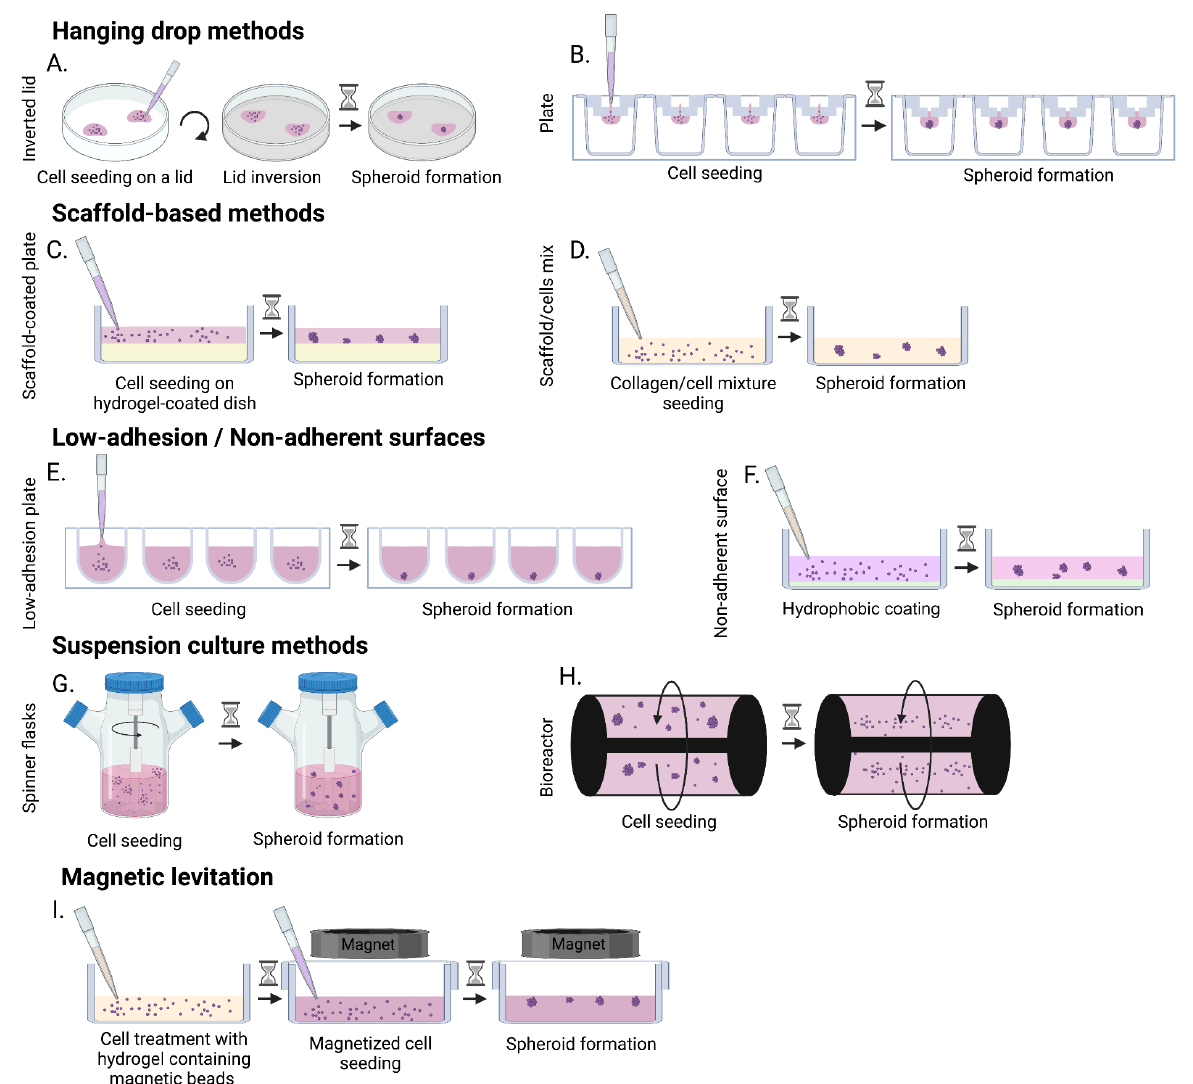
Figure 2. Common techniques used to generate 3D spheroids. Hanging drop methods: Either a suspension of cells is deposited on a petri dish lid which is inverted over a petri dish ( A ), or in a well and passes through a micro-well to form a drop ( B ). Scaffold-based methods: Either cells are seeded on a hydrogel-coated petri dish ( C ) or they are embedded in the hydrogel and seeded in a petri dish ( D ). Low-adhesion/non-adherent surfaces: Cells are seeded in low-adhesion wells to form one spheroid per well ( E ) or on non-adherent surface coated with a hydrophobic substance to prevent cells from spreading ( F ). Suspension culture methods: Cells are placed in spinner flasks ( G ) or in bioreactor ( H ) and put under dynamic culture conditions. Magnetic levitation: Cells